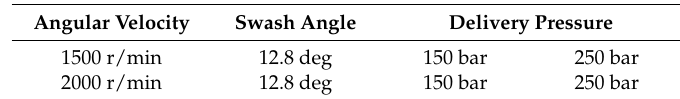
Operating conditions considered for the acceleration measurements in healthy and faulty